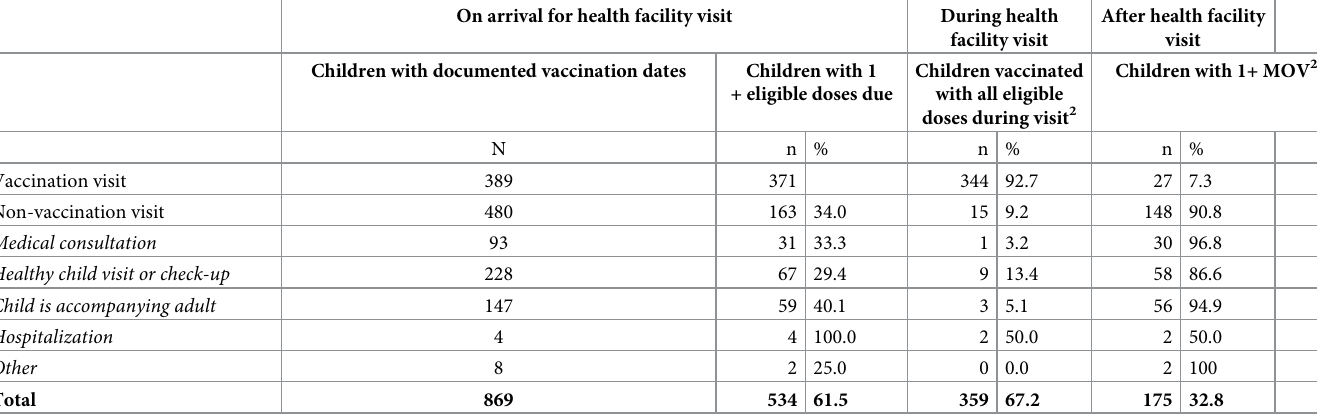
Table 4. Prevalence of missed opportunities for vaccination (MOV) 1 among surveyed children 0–23 months, by reason for visit, Ondo State, Nigeria,